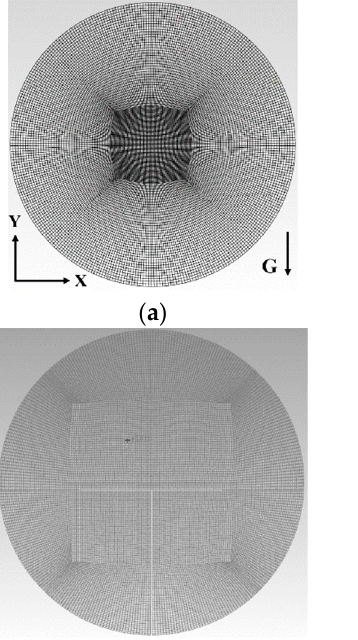
Figure 3. Pressure with various mesh numbers.